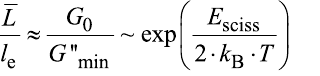
predicted for linear wormlike micelles by theoretical considera- tions ( ≈ 2.25) [32] but matches the values, that were found for branched wormlike micelles ( ≈ 1.8) [37,38]. Interestingly, τ R